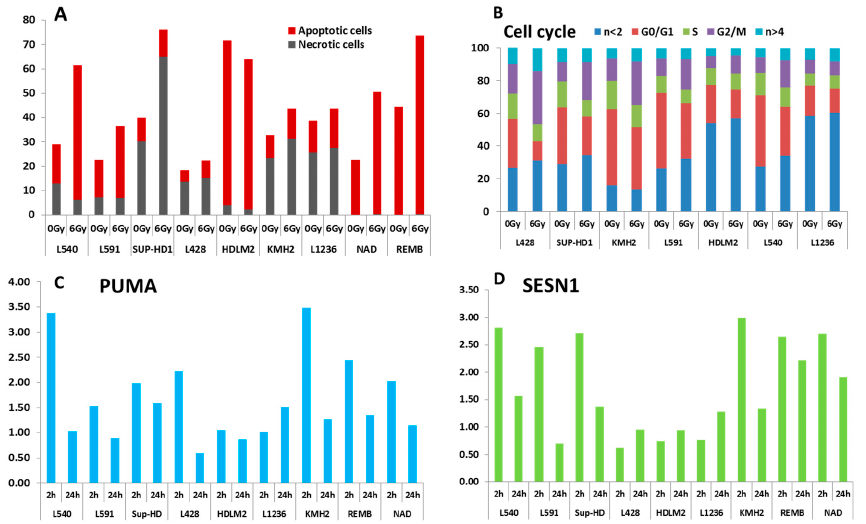
Figure 12. Radiation sensitivity of HL cell lines. ( A ) Apoptotic and necrotic cells after 24 h of exposure to 6 Gy. Lymphoblastoid B cell lines (REMB and NAD) where used as a control. ( B ) Analysis of the cell cycle after 24 h of exposure to 6Gy. ( C ) PUMA and ( D ) Sesterin 1 (SESN1) gene expressions were analyzed at 2 and 24 h after 2Gy irradiation by quantitative RT-PCR. Values are normalized to HPRT expression levels. The gene expression ratio of irradiated/mock-treated cells is presented. The mean values of triplicate experiments, each with three RT-PCR reactions, are shown.